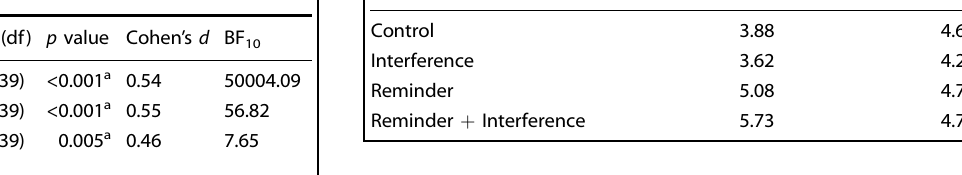
‘ Remember ’ reports (with Cohen ’ s d effect size and Bayes factors included).